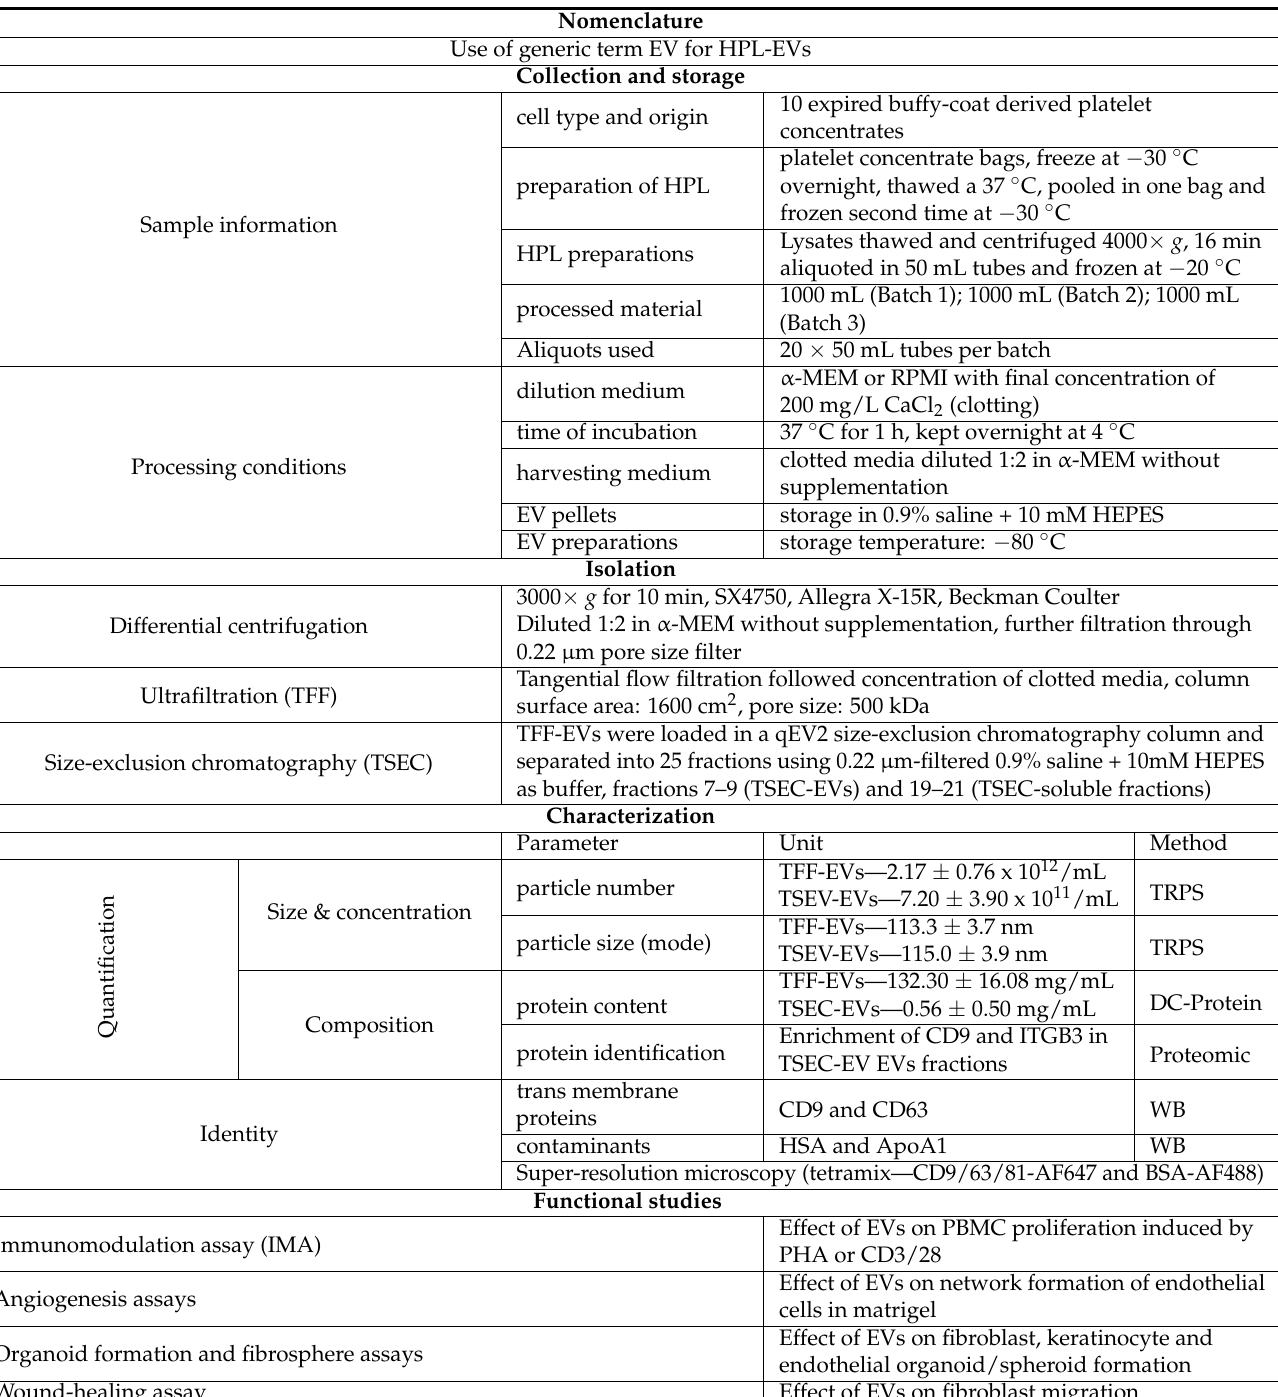
Table A1. Adherence to MISEV criteria for HPL-EV preparations. Used nomenclature, material collection and storage, EV-isolation strategy, characterization and functional studies performed are